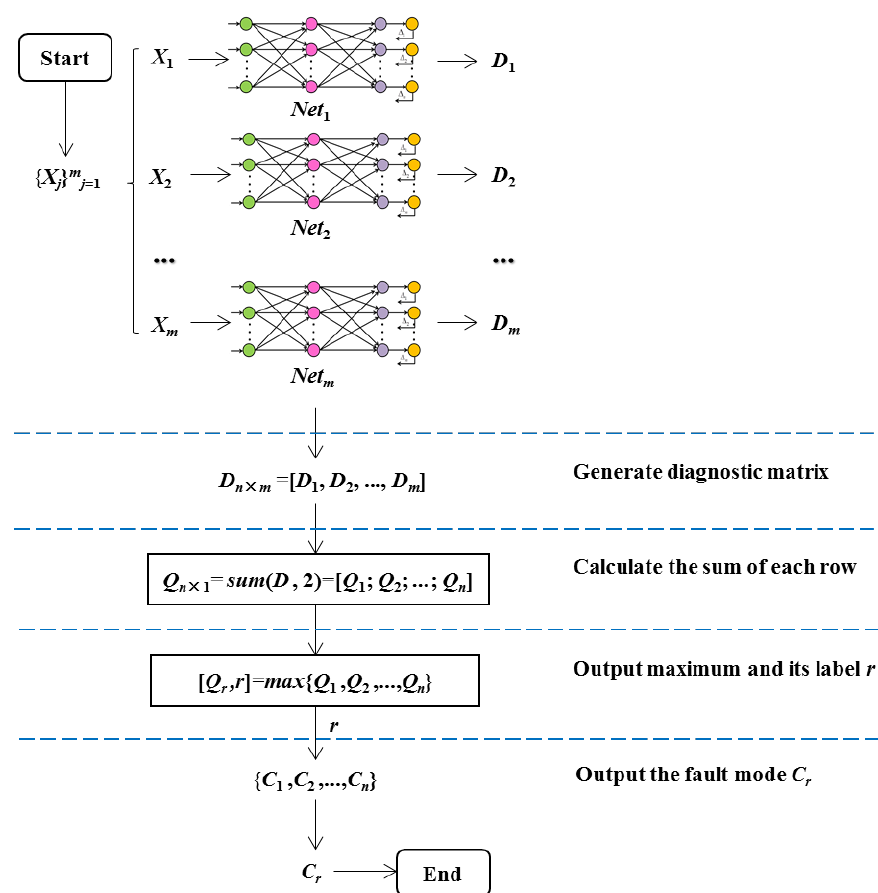
Figure 3. Decision fusion algorithm based on the voting method.